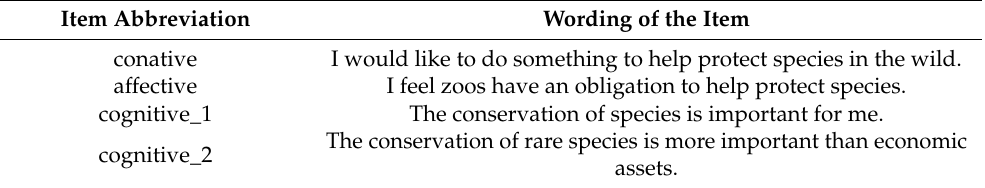
Table 1. Items used to measure attitudes toward species conservation. The wording of cognitive_1 was slightly changed for this study compared to the original